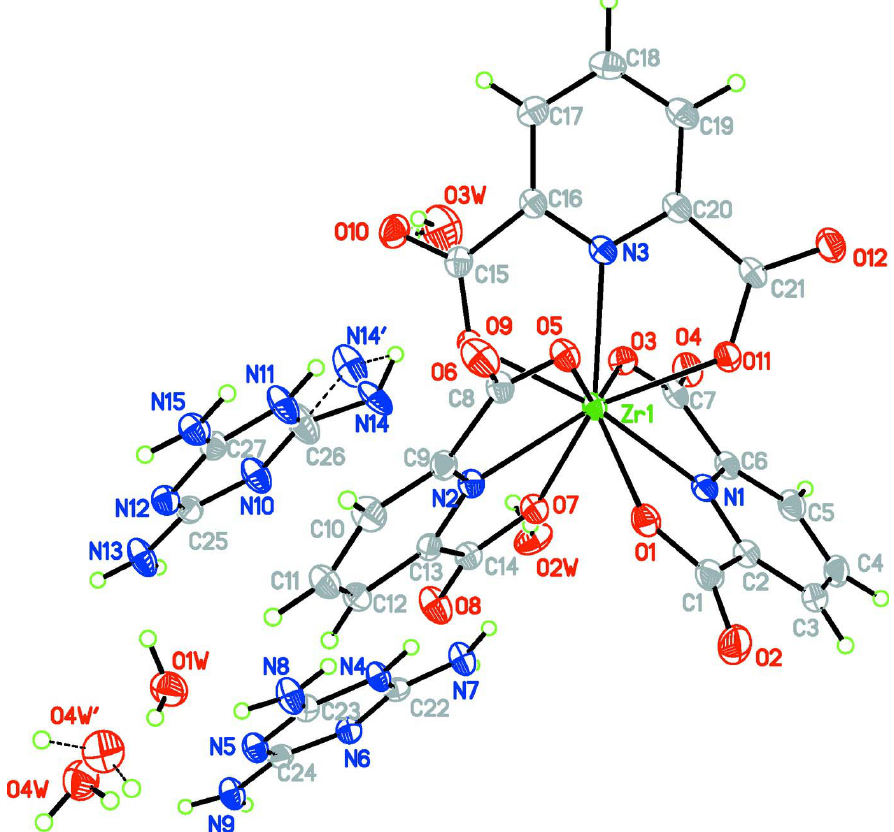
Figure 1 A view of the title compound showing thermal ellipsoids at the 50% probability